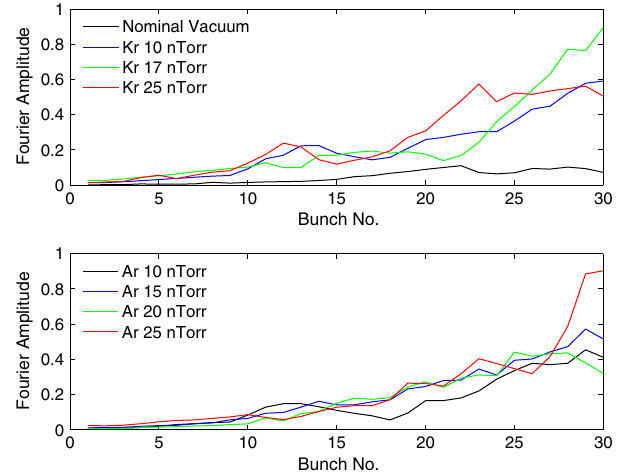
FIG. 14. Amplitude at vertical tune, obtained from FFT of vertical bunch motion (in mm), as a function of bunch number at different pressures for 0 . 5 mA = bunch